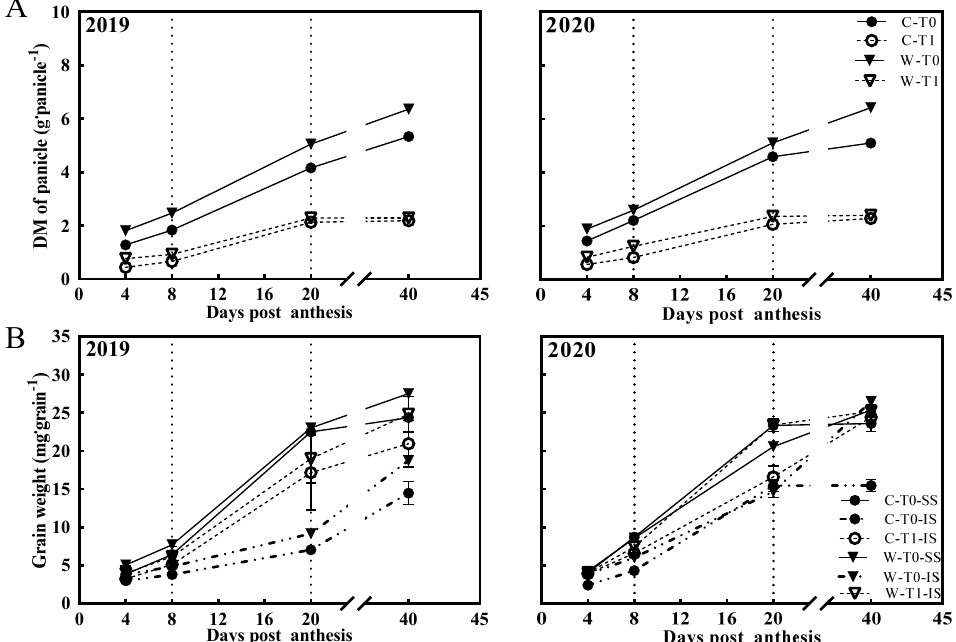
Figure 1. DM weight of panicles ( A ), SS and IS ( B ) during grain filling. C, CJ03; W, W1844; T0, control group; T1, top 2/3 of the spikelets were removed; SS, superior spikelets; IS, inferior spikelets; vertical bars represent mean values ± SE ( n = 3).